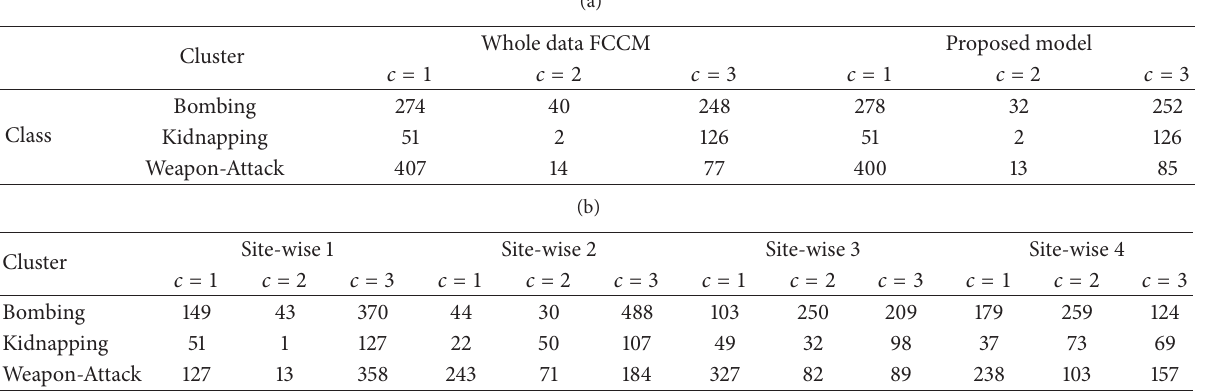
Table 4: Comparison of cross tabulation tables of object partition (terrorist